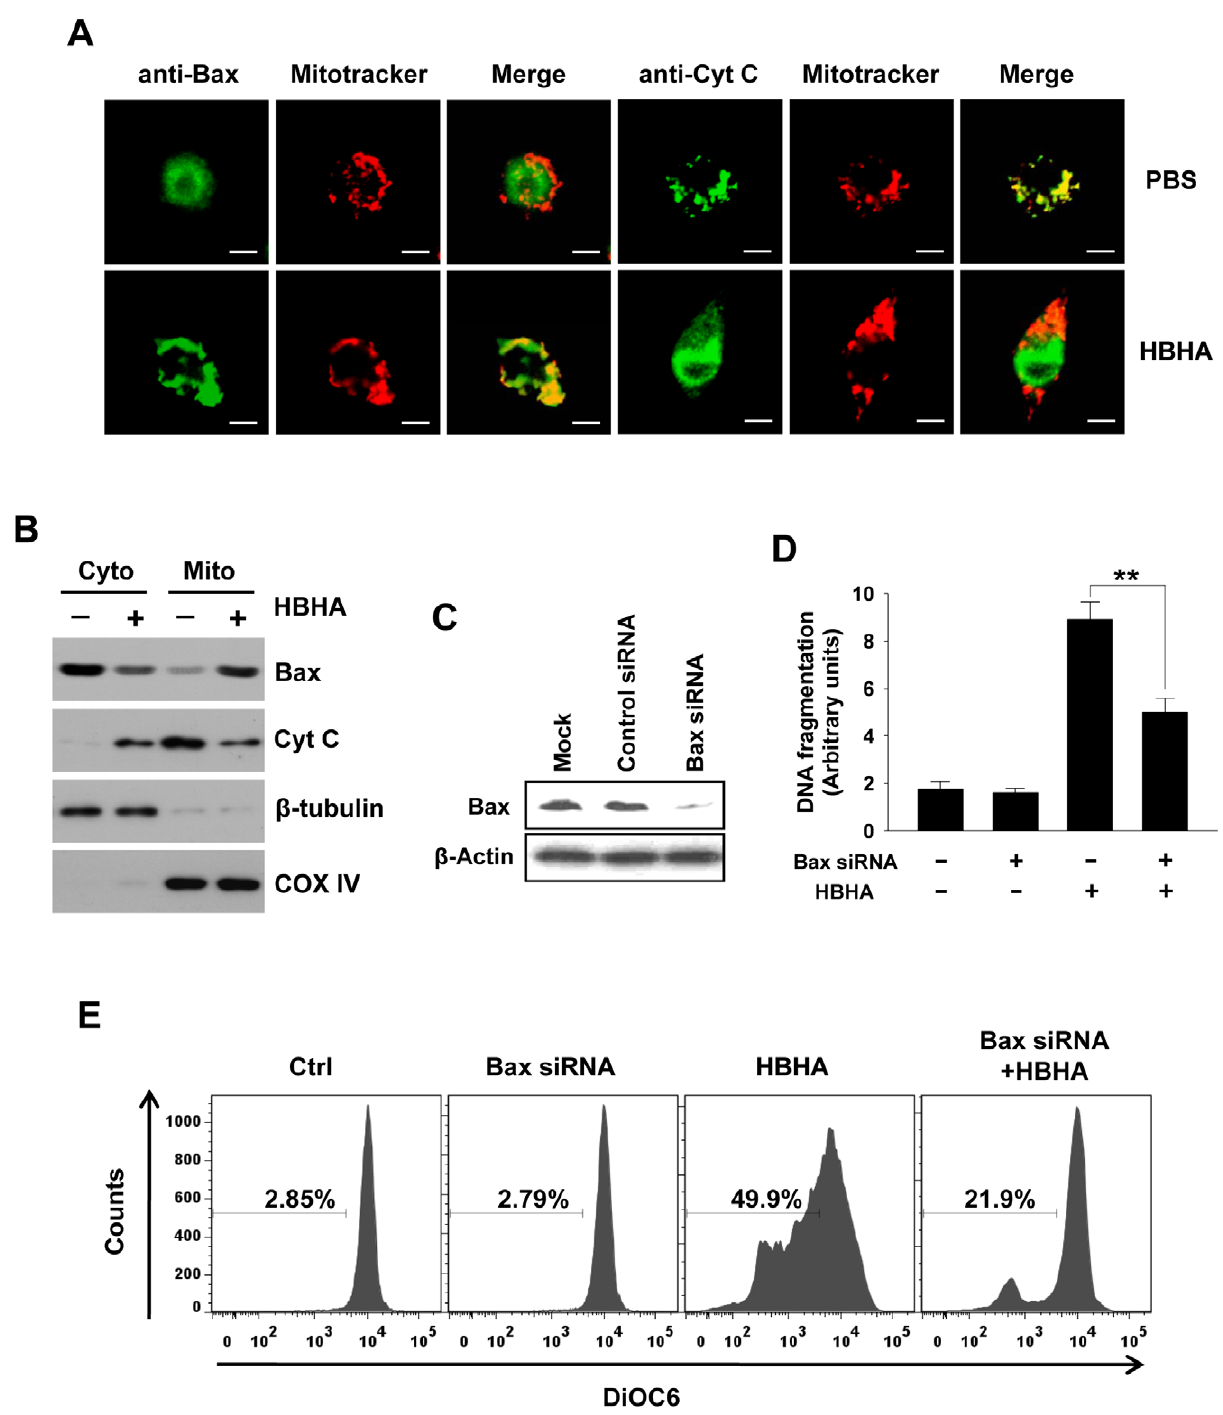
Figure 3. Bax translocation and cytochrome c release by HBHA treatment in macrophages. ( A ) RAW 264.7 cells were incubated with HBHA (10 m g/mL) or PBS for 20 h. Bax and Cytochrome c were stained with their antibodies and then an FITC-conjugated secondary antibody (green). Mitochondria were stained with Mitotracker Red (red). Cells were then imaged by confocal microscopy. Scale bar, 5 m m. ( B ) Mitochondrial and cytosolic fractions were prepared, and aliquots containing 20 m g of protein were subjected to Western blot analysis and probed with antibodies for Bax and cytochrome c (Cyt C) as described in the Materials and Methods. COX IV and b -tubulin were used as markers for the mitochondrial and cytosolic fractions, respectively. Results are representative of three independent experiments. ( C ) Western blot analysis of expression of Bax in RAW 264.7 cells transfected with liposomes only (Mock), nonspecific siRNA (Control siRNA), or Bax-specific siRNA. Western blotting was done using an antibody against Bax and an antibody against b -actin as a loading control. ( D,E ) Parental cells and Bax siRNA-transfected cells were treated with HBHA (10 m g/mL) for 24 h or 48 h. DNA fragmentation was determined by Cell Death Detection ELISA as described in Figure 1 ( D ). Loss of DY m was assessed by